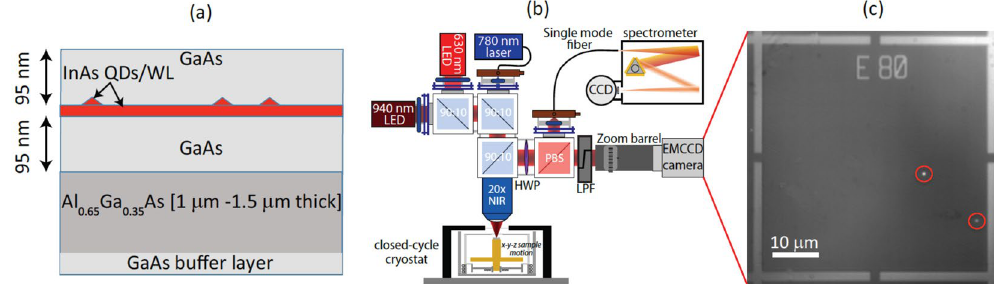
Figure 1. Sample structure and experimental set up ( a ) Schematic of the sample under study (not to scale), comprising a single layer of InAs quantum dots (red triangles), grown on an InAs wetting layer (WL) between two 95 nm thick layers of GaAs, and situated on top of a 1 μ m or 1.5 μ m thick Al 0.65 Ga 0.35 As layer on a GaAs buffer layer followed by a GaAs substrate. ( b ) Schematic of the photoluminescence setup. An infrared light emitting diode (LED, emission centered at 940 nm) is used for illumination of the sample while either a 630 nm red LED or a 780 nm laser is used for excitation of the quantum dots (QDs), depending on whether excitation over a broad area (LED) or of individual QDs (laser) is required. Samples are placed within a cryostat on an x-y-z positioner. Imaging is done by directing the emitted and reflected light into an Electron Multiplied CCD (EMCCD) camera, while spectroscopy is performed by collecting emission into a single-mode fiber and sending it to a grating spectrometer. ( c ) EMCCD image of the photoluminescence from two QDs (highlighted by red circles) and reflected light by the alignment marks (metallic crosses), acquired by illuminating the sample simultaneously with both the red and near-infrared LEDs, at a temperature of 4 K.